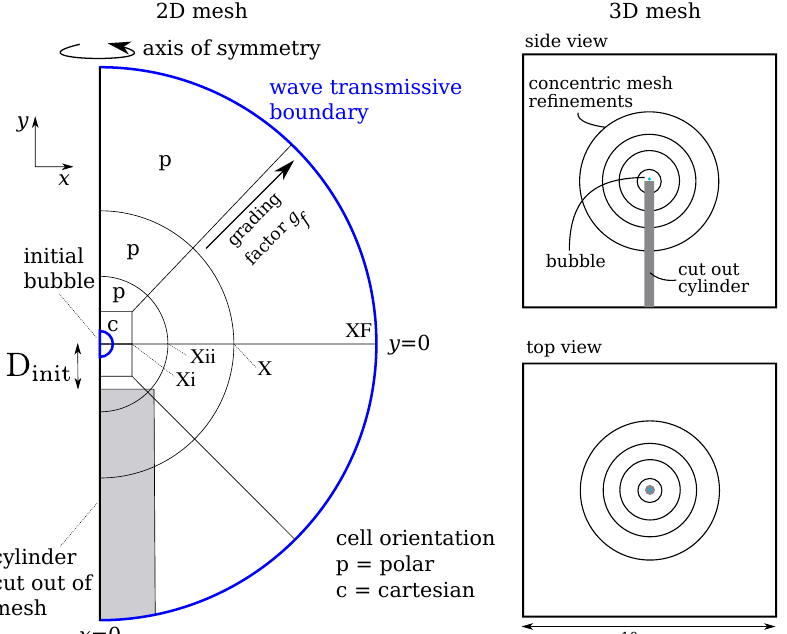
Figure 3. Sketch of the numerical set-up (not to scale) and grid parameters of the 2D mesh ( left ) and sketch of the computational domain and refinement regions for the Cartesian 3D mesh ( right ). The 2D mesh consists of 106827 cells. The Cartesian 3D mesh consists of 5.2 million